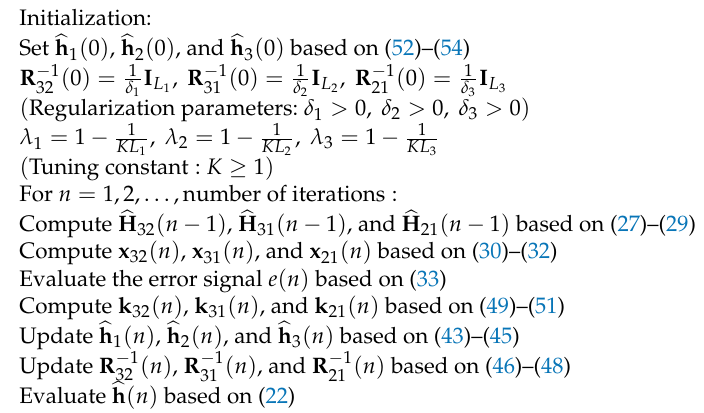
Table 1. RLS algorithm for trilinear forms (RLS-TF).